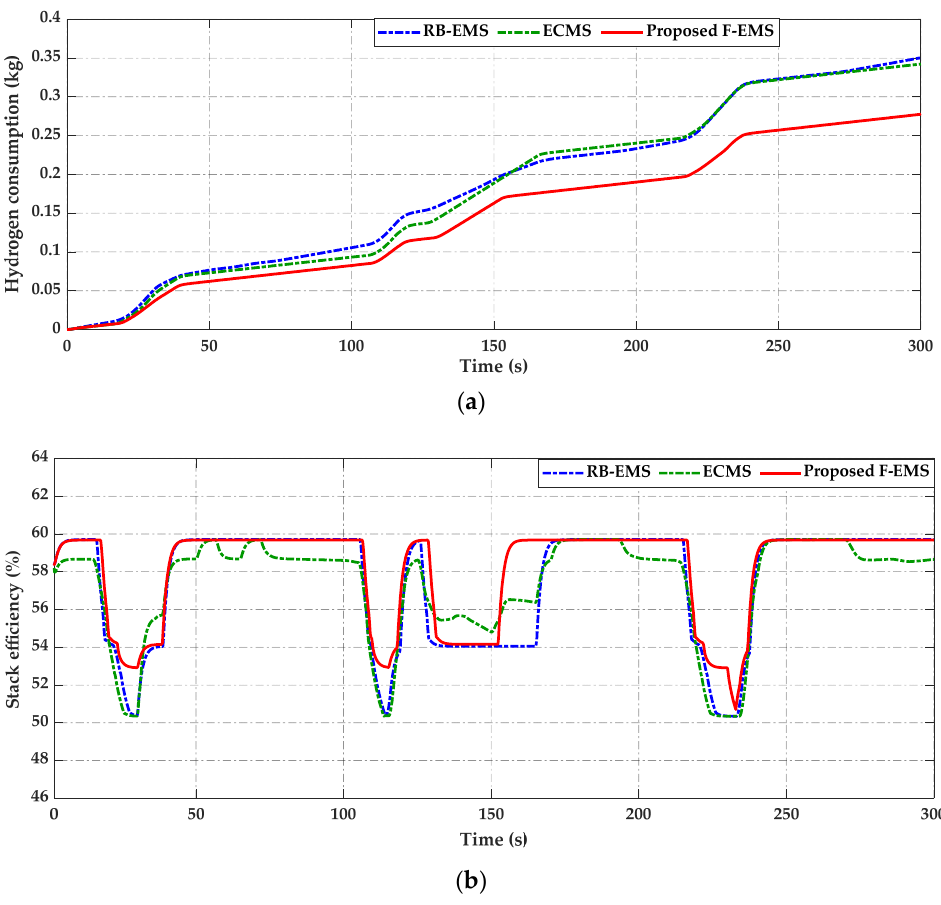
Figure 13. The comparison of fuel consumption and efficiency of PEMFC stack. ( a ) Hydrogen consumption; ( b ) Stack efficiency.